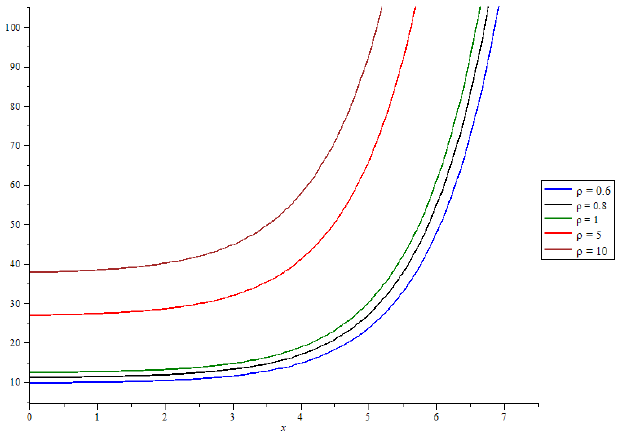
Figure 2. European call-option prices with various fractional-order ρ values.